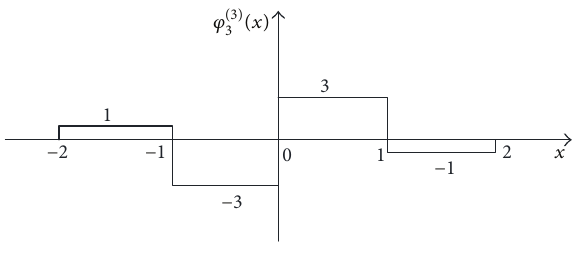
(𝑥) . Figure 2: Variation value of function 𝜑 (3) beam described in Figure 1. The beam is discretized along 3 the beam axis through uniformly scattered spline nodes on the entire beam. The tapered beam can be divided by